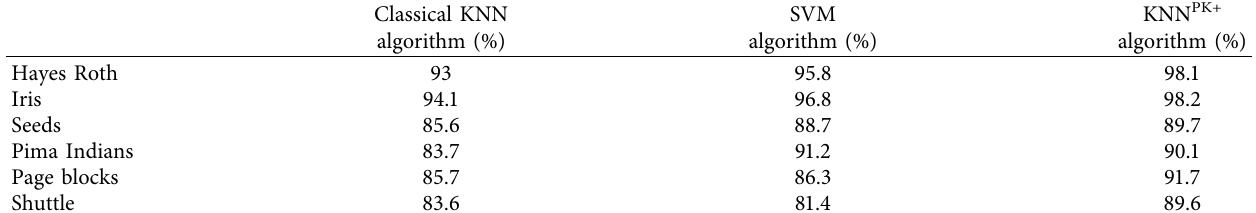
Table 6: omparison of classification accuracy of three algorithms